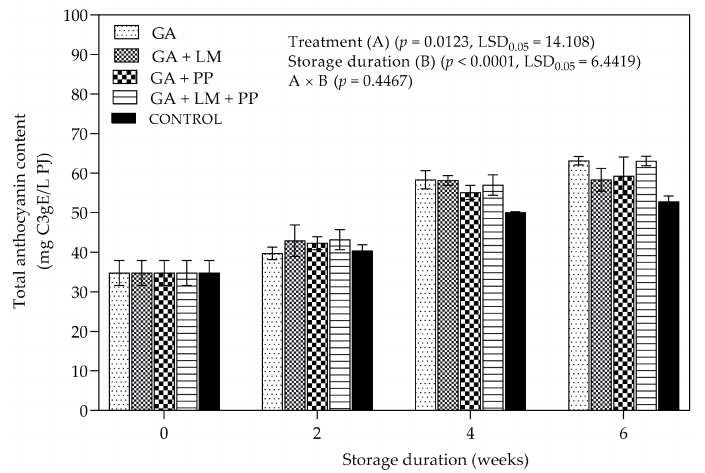
Figure 11. Total anthocyanin content (mg C3gE/L PJ) of ‘Wonderful’ pomegranate whole fruit coated with gum arabic (GA) coatings enriched with lemongrass oil (LM) (0.1% v/v ) and/pomegranate peel extract (PP) (1% w/v ) and stored at 5 ± 1 ◦ C (95 ± 2% RH) for 6 weeks followed by 5 d at shelf-life conditions (20 ± 1 ◦ C and 60% RH). Vertical bars represent the standard error (SE) of mean values calculated from three measurements (Aril juice extracted from 10 fruit = 1 replicate = 1 measurement). LSD 0.05 represent least significant difference ( p <